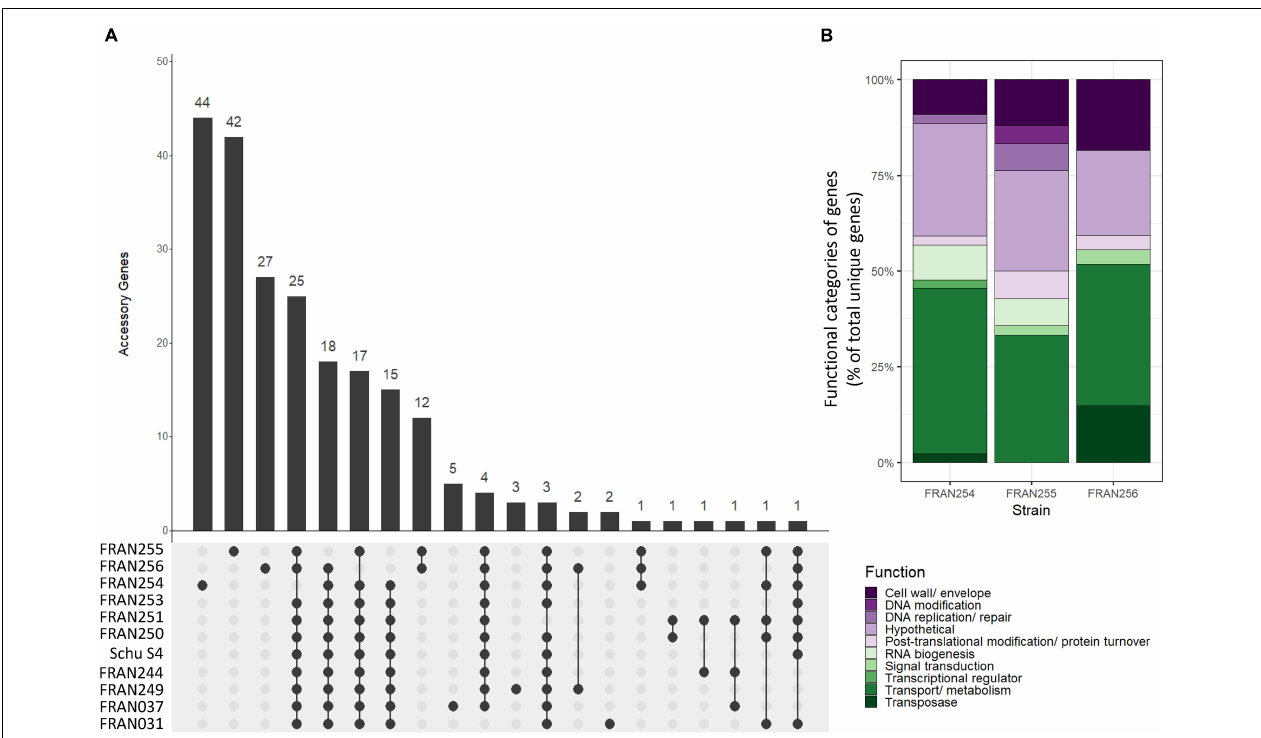
FIGURE 3 | UpSet plots based on gene conservation across the F. tularensis panel. (A) UpSet plots show the intersections of gene groups among all strains. Strains are indicated in the rows, while intersections are shown in the columns. Filled circles indicate the presence of a specific subset of genes within that strain while empty circles indicate absence of the gene set within a strain. The bar graph above shows the size of each gene group intersection. For example, the first bar shows 44 genes that are unique in FRAN254, since the only filled circle corresponds to FRAN254; however, the fourth bar indicates a set of 25 genes that are conserved in all strains with the exception of FRAN254. (B) Stacked bar chart showing gene groups unique to FRAN254, FRAN255, and FRAN256, with colored bars indicating the functional categories assigned to each gene as a percent of the total genes.